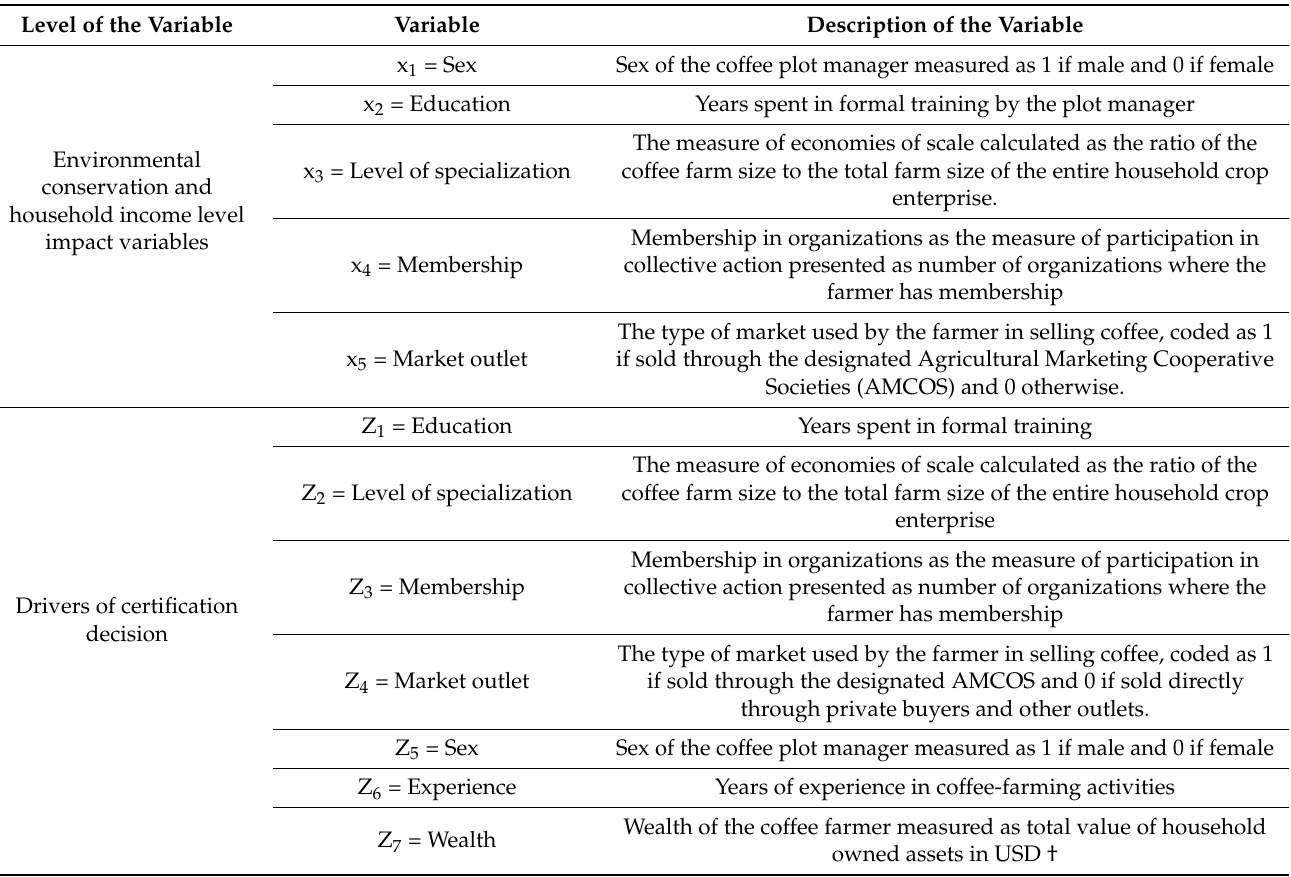
Table 1. Description of variables for the endogenous switching regression